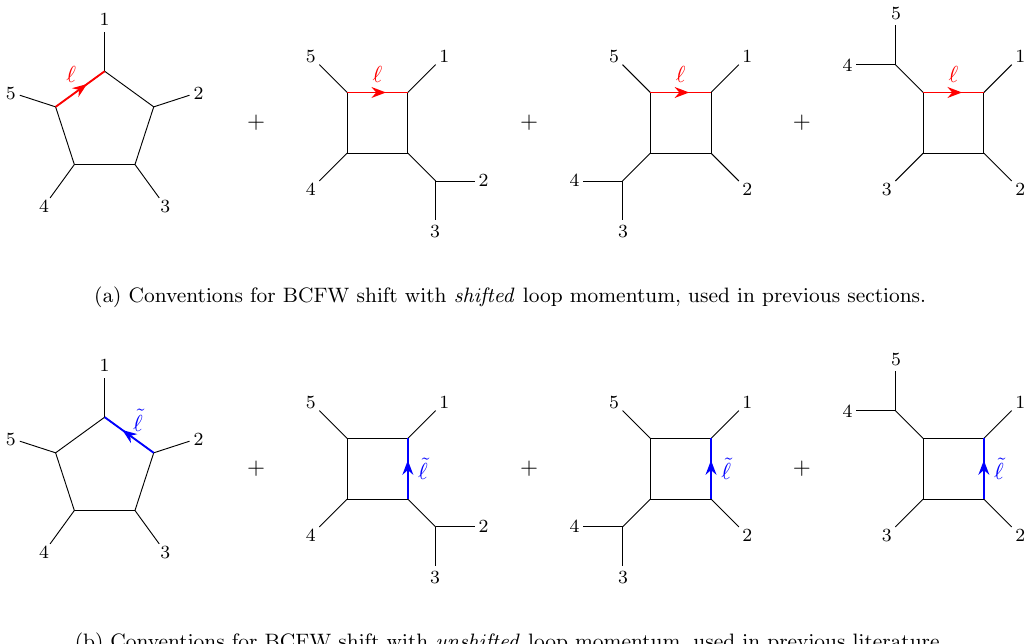
Figure 6 . Diagrams contributing to the (cid:12)ve-point MHV amplitude, with two di(cid:11)erent conventions for the de(cid:12)nition of the loop momentum. In both cases, we have chosen the conventions such that only one term per diagram contributes in the forward